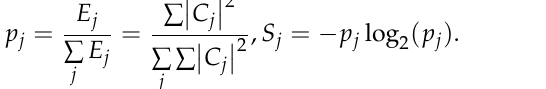
where C j , E j , p j denote wavelet coefficient, wavelet energy and relative energy in scale j , j = 1, 2,